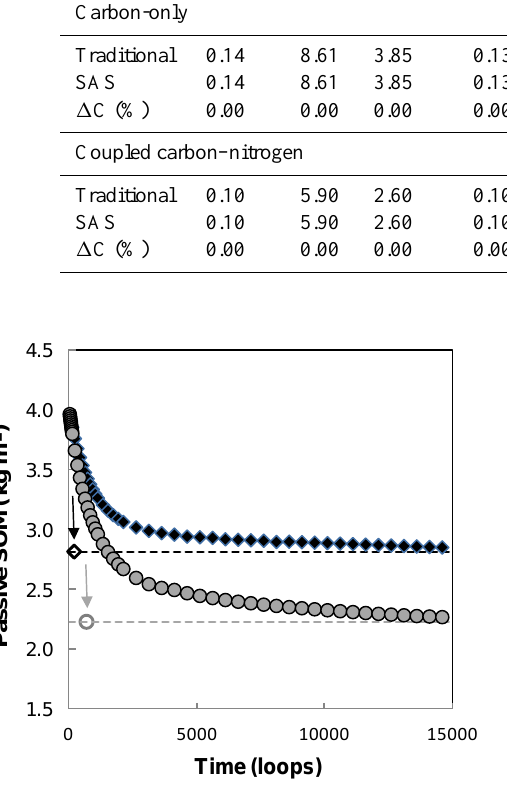
Fig. 6. Dynamics of global mean passive soil carbon pool in carbon- only (filled black diamonds) and coupled carbon–nitrogen (filled gray circles) simulations with traditional method and the SAS framework (dotted lines). The arrows and blank symbols show the times and values estimated with the SAS framework for carbon-only (black) and coupled carbon–nitrogen (gray)